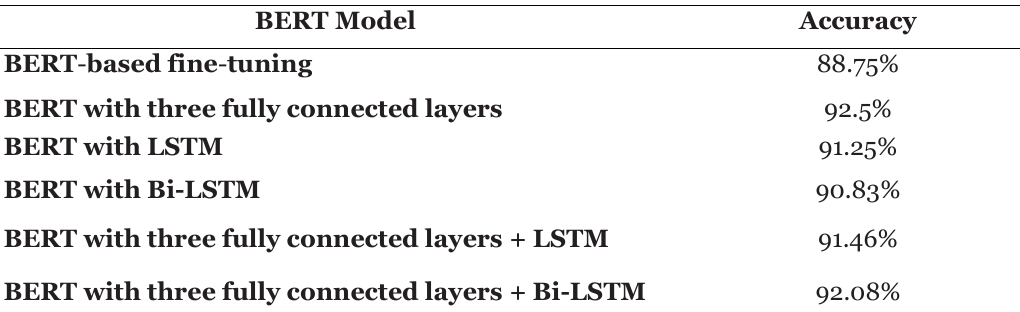
Accuracies of the Different